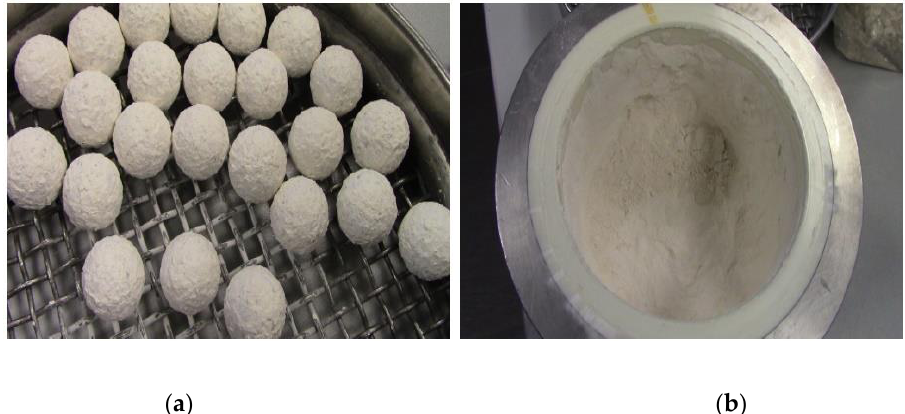
Figure 4. ( a ) Sample of white silicon dioxide before grinding; ( b ) Sample of the white silicon dioxide after pre-griding in PM 400 .